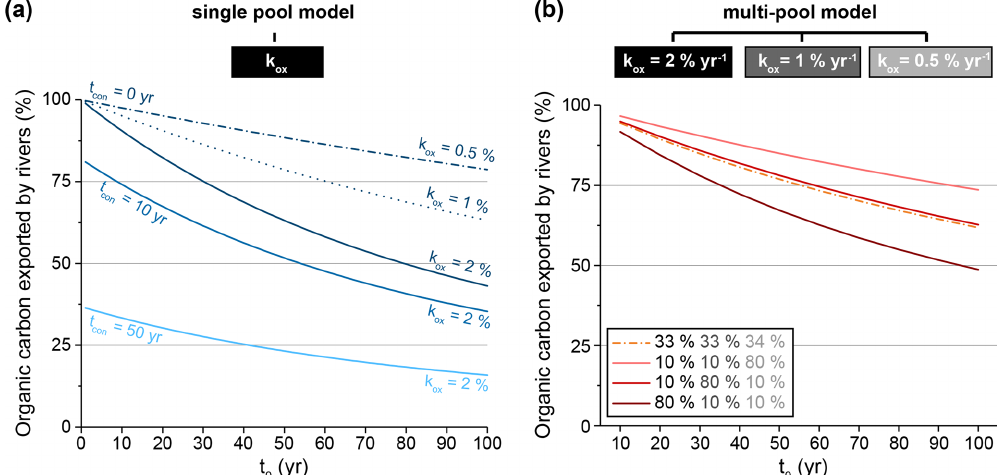
Figure 3. The proportion of landside-mobilized OC that is exported by rivers for a single landslide and different OC oxidation models, plotted as a function of the total export time ( t 0 ). (a) Results from the single pool model using different values of the oxidation rate constant: k ox = 0 . 5%yr − 1 , 1%yr − 1 and 2%yr − 1 . Three different times of connection to the river network are also shown ( t 0 = 0, 10 and 50 years). (b) Results from the multi-pool model. Here the landslide is initially connected to the river ( t con = 0 years). The different lines represent model outcomes with different proportions of OC in the three modeled pools, as indicated by the greyscale text. Note that a larger fraction of OC in the high-reactivity pool leads to a decrease in the proportion of OC that can be exported by the river